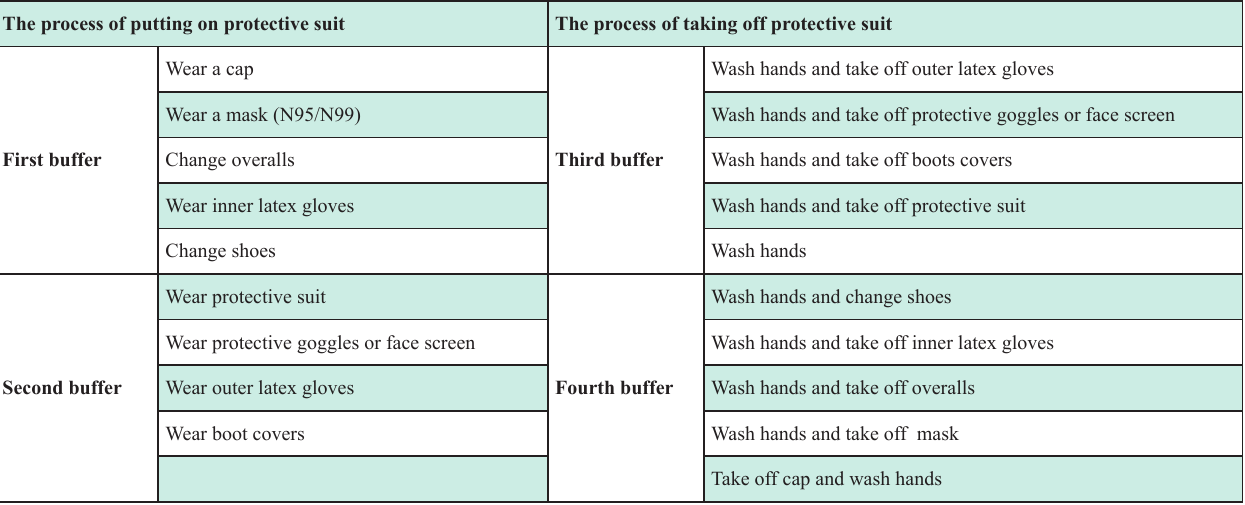
Figure 21 The procedure for putting on and removing personal protective